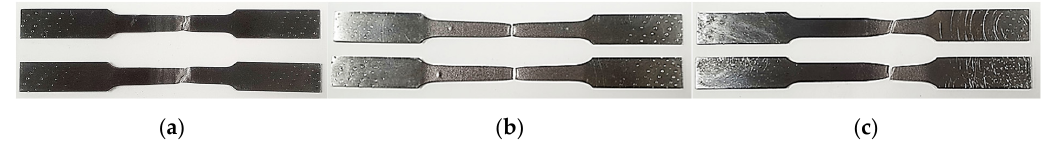
Figure 16. Fractured specimens after tensile tests: ( a ) P21; ( b ) STS316L; ( c ) FGM.